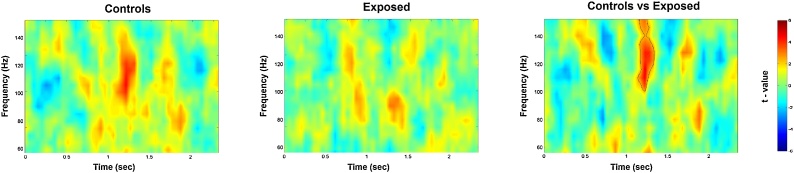
Sensor-level spectral maps conveying empathy for pain. The statistical maps of Pain vs no-Pain stimuli are averaged above all sensors in the two groups (left and middle panels), and in the contrast between the two groups (right panel). The contoured pattern illustrates statistically significant (p cluster-cor < 0.05) time-frequency windows resulting from comparing the two experimental groups.